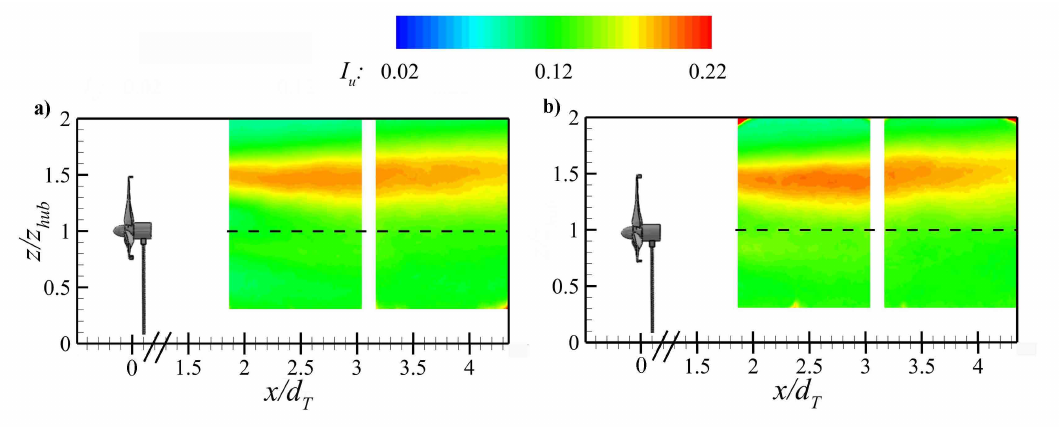
Figure 11. Normalized streamwise wake velocity fluctuation I u under α = ( a ) 0 ○ and ( b ) 90 ○ . The dash-dotted lines refer to positions of the upper and lower blade tips.